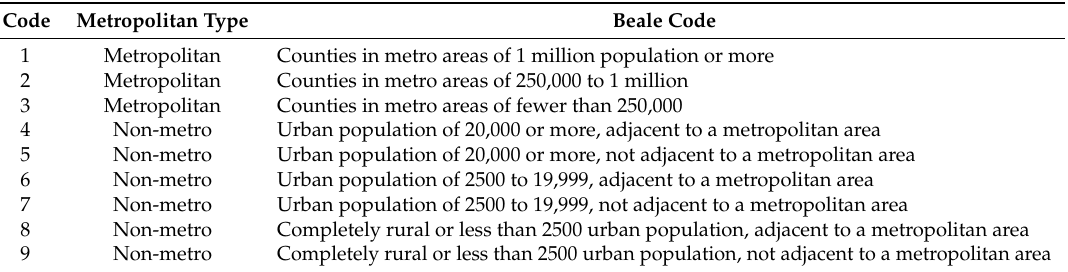
Table 1. Beale Rural Urban Classification Codes (RUCC) 1973, 1983, 1993, and